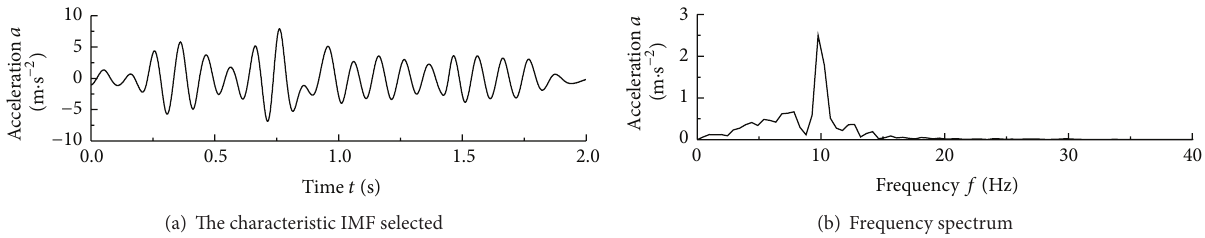
Figure 11: Analysis results of the signal presented in Figure 10 by improved EMD: (a) the characteristic IMF and (b) FFT spectrum.